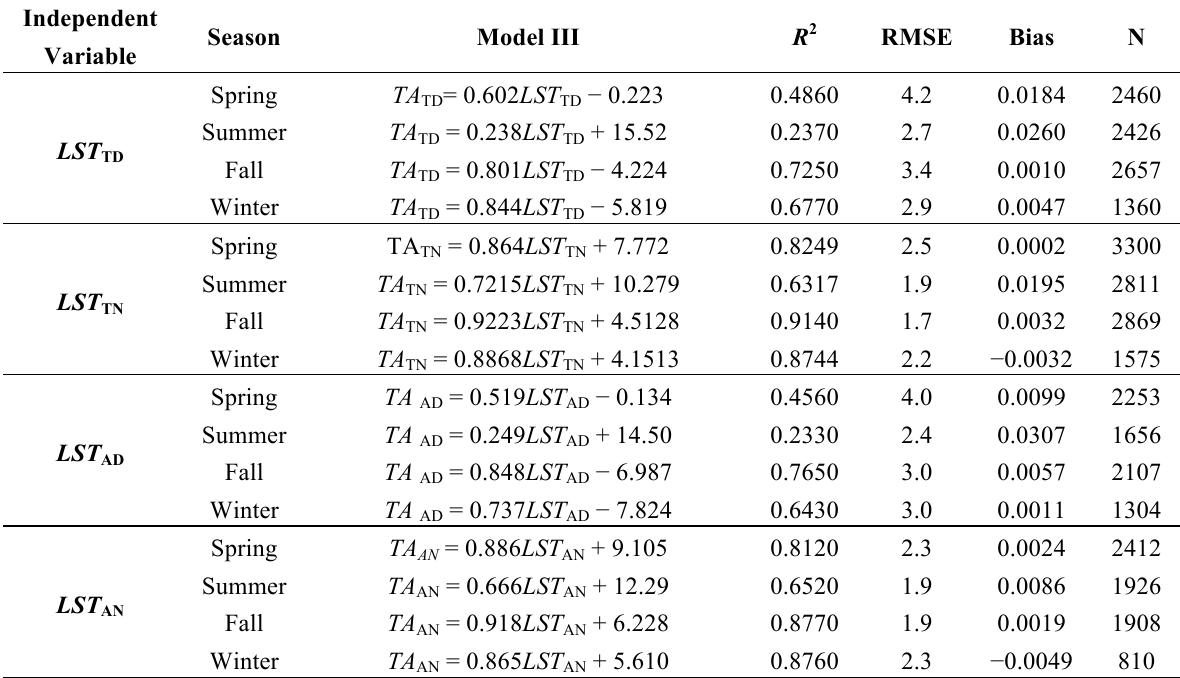
Table 3. The seasonal estimation models for daily mean air temperature ( TA ) based on the corresponding land surface temperature (LST) data from meteorological stations in rural regions ( i.e. , Model